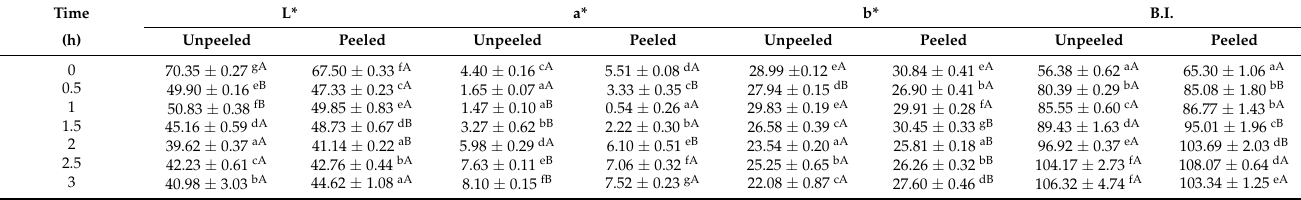
Figure 1. The appearance of roasted sweet potatoes. ( a ) Unpeeled; ( b ) Peeled. Table 1. The influence of different roasting treatments on the color change of sweet